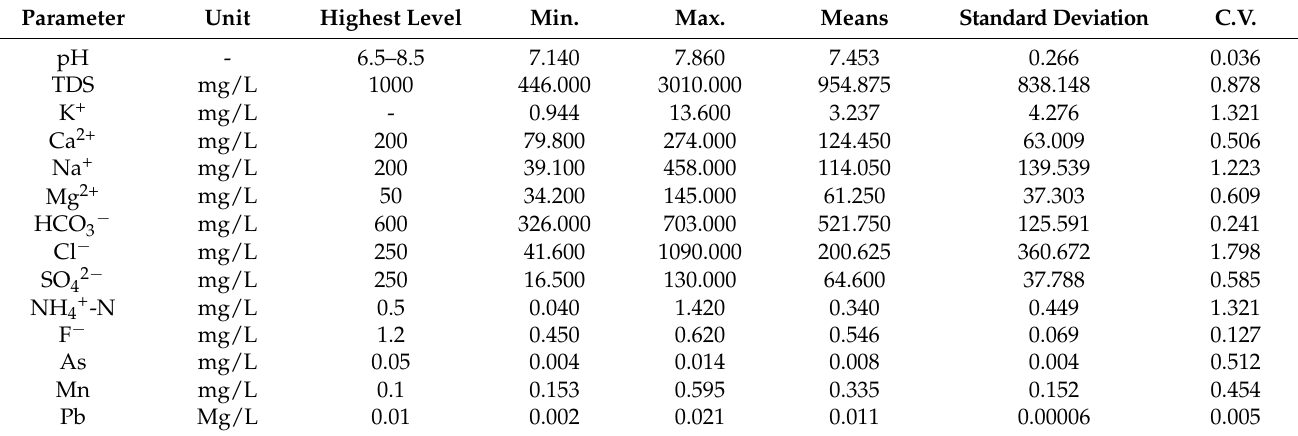
Table 3. Reference values for water chemistry characteristics in the study